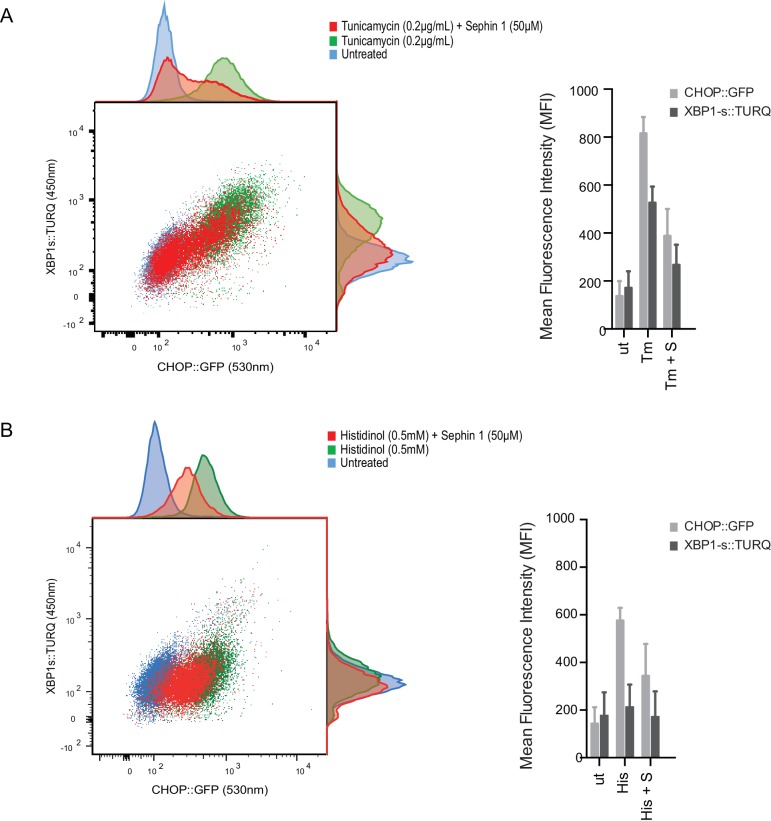
Sephin1 broadly attenuates the ER stress response in cultured CHO cells.(A) Two-dimensional plot of the fluorescence signals derived from CHO cells stably transduced with both a CHOP::GFP reporter (on the horizontal axis, Ex: 488 nm/ Em 530 ± 30 nm; reflecting mostly ISR activity) and a XBP1::Turquoise reporter (on the vertical axis, Ex: 405 nm/ Em 450 ± 50 nm; reflecting IRE1α activity) analysed by flow cytometry. Color-coded signals from untreated cells (blue) or cells exposed to a low concentration of tunicamycin (0.2 µg/mL; 20 hr) alone (green) or together with Sephin1 (50 µM, red) are superimposed. Histograms of the distribution of the two reporter signals in the three cell populations are plotted on the corresponding axis and the mean ± CV (coefficient of variation) of the fluorescence intensity of the two reporters is depicted in the bar diagram to the right. (B) As in ‘A’ above, but the cells were exposed to histidinol, an ISR inducer that does not promote unfolded protein stress in the ER and does not activate the XBP1::Turquoise reporter. Shown is one of three independent experiments.